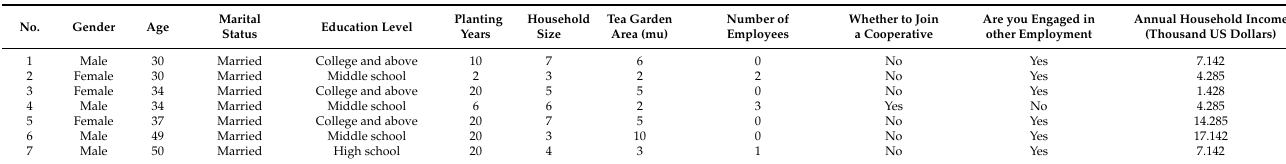
Table A1. Demographic characteristics of pre-interviewed tea farmers.